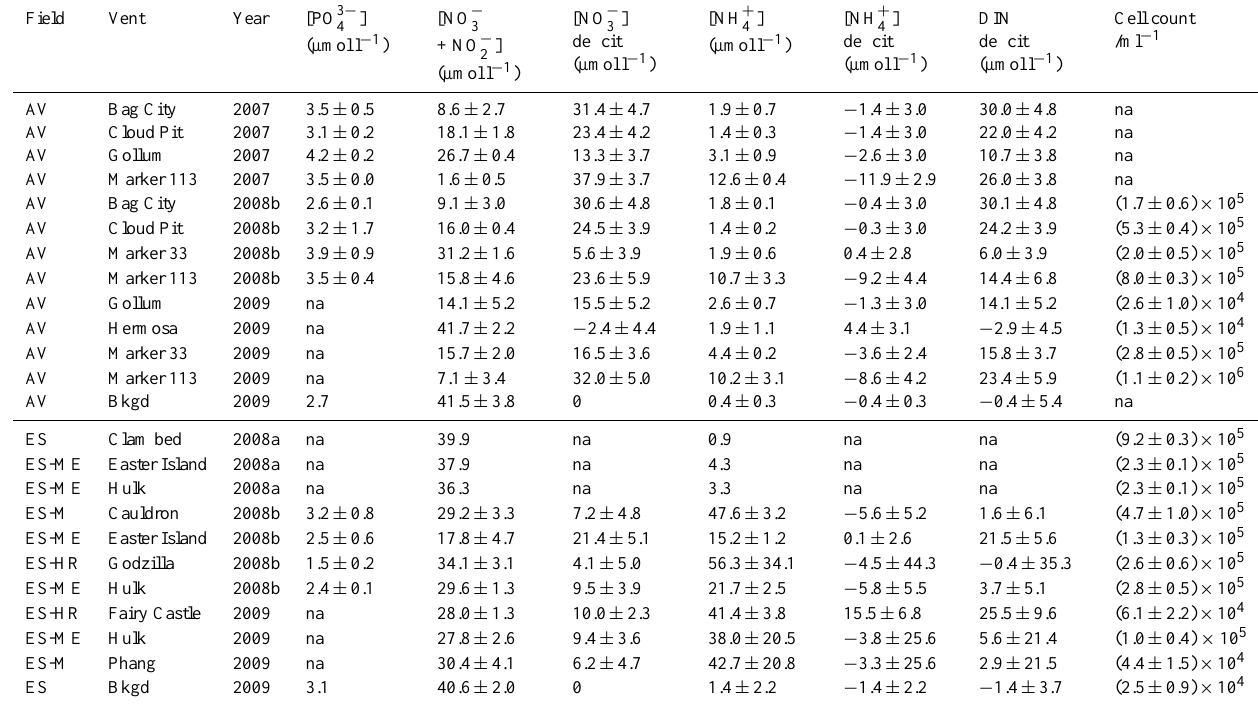
Table 1. (continued) Physico-chemical properties of the sampled vent fluids at Axial Volcano and the Endeavour Segment on the Juan de Fuca